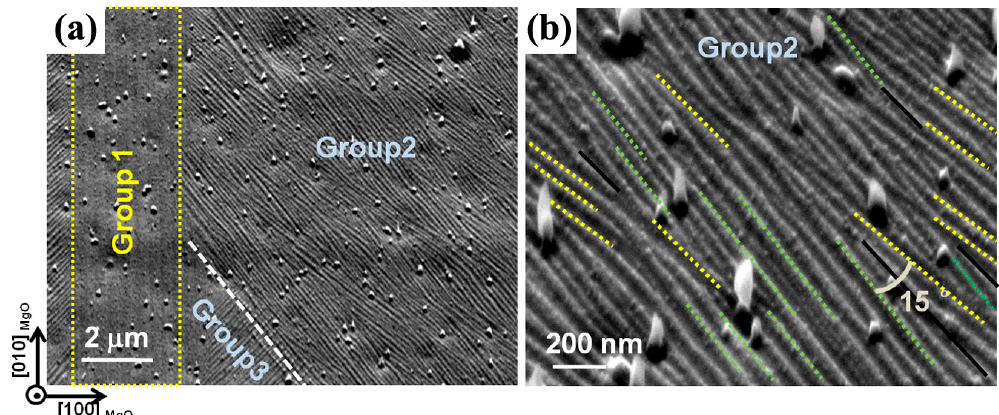
Figure 13. ( a ) Microstructure of 7M martensite with low relative contrast (Group 1) and high relative contrast (Group 2 and Group 3); and ( b ) magnified image of individual plates belonging to Group 2.